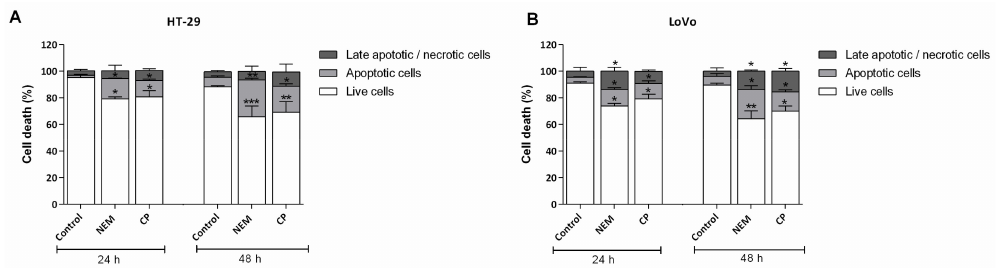
Figure 4. E ff ect of NEM (IC 50 ) and CP (IC 50 ) on apoptosis of HT-29 ( A ) and LoVo ( B ) cell lines. Data are presented as mean ± S.D. of three independent experiments. * p < 0.05, ** p < 0.01, *** p < 0.001 vs. untreated